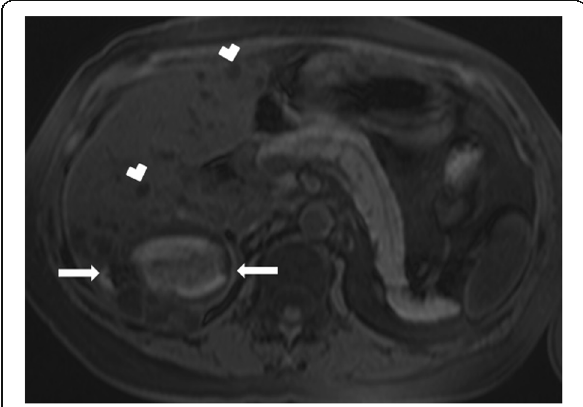
Fig. 3 A 44-year-old female patient with known PLD presenting with right upper quadrant pain. On the US, a large hyperechoic mass was found in the right hepatic lobe (not shown). Axial plane precontrast T1W MR image shows subcentimeter cysts (arrowheads) and a cystic lesion with hyperintense content (arrows). There was no discernible enhancement on postcontrast series (not shown).